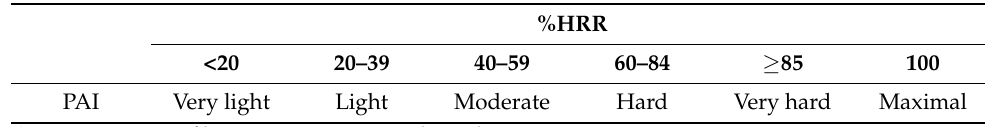
Table 3. The classification of physical activity intensity by